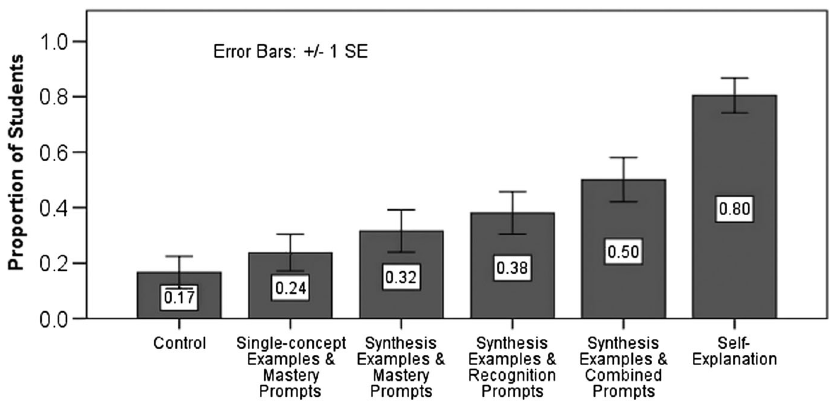
FIG. 7. Proportion of students in each condition who employed the correct solution structure on the target synthesis problem. Error bars are standard